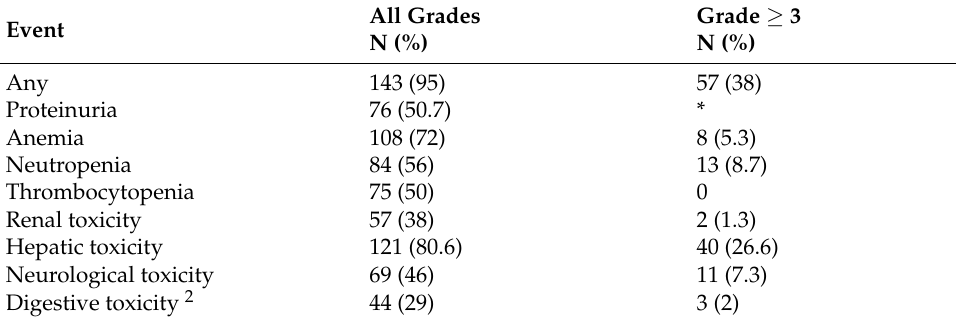
Table 2. Adverse events of bevacizumab and chemotherapy 1